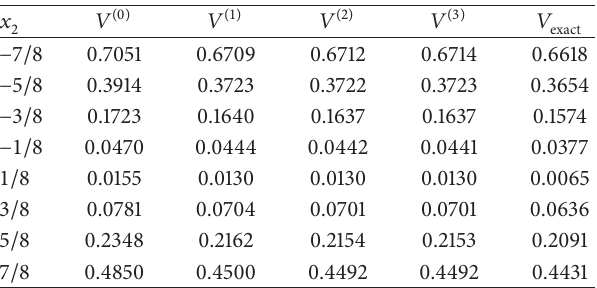
Table 2: Iteration results 𝑉 (𝑖) for Example 1 when 𝑚 = 8 and 𝑥 1 = −1/8 .